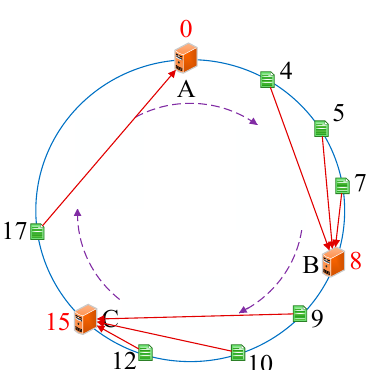
Figure 8. The deploying result of applications using the dynamic consistent hashing (DCH) algorithm.